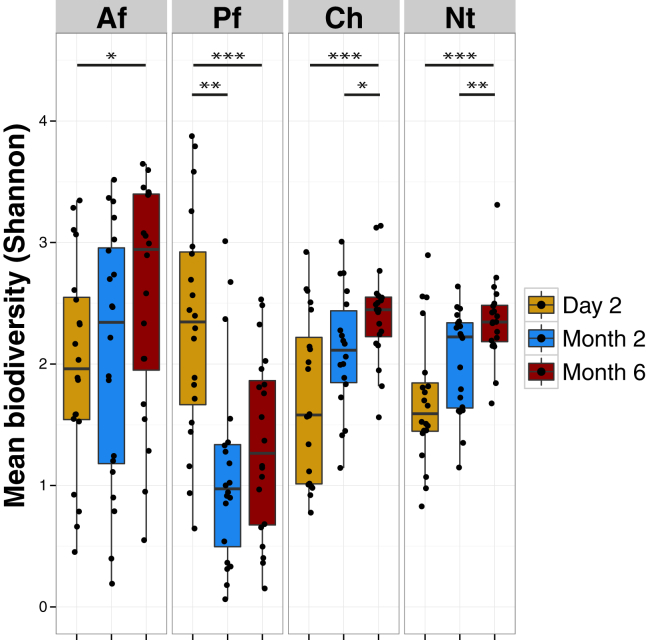
Changes in bacterial biodiversity with age. Mean Shannon diversity, calculated based on the richness and evenness of taxa within the community, at each time point is shown. *P < .05, **P < .01, and ***P < .001. Ch, Cheeks; PC, principal component.